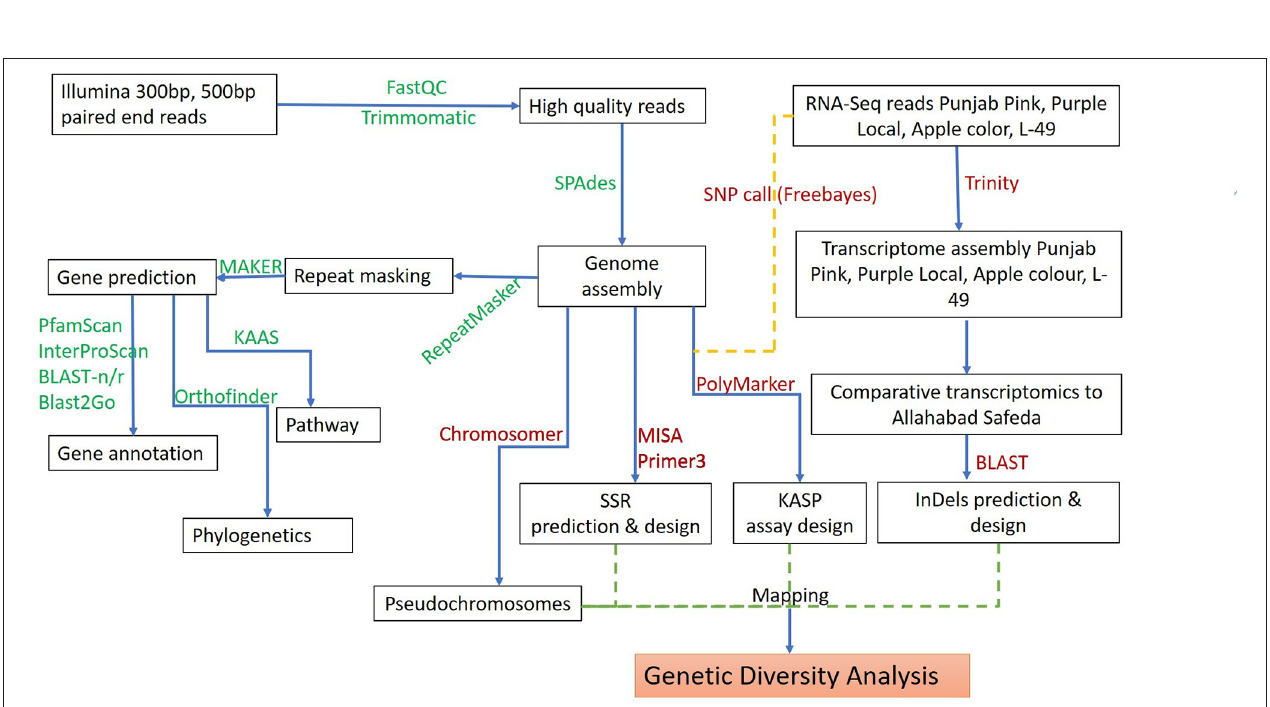
FIGURE 1 | Schematic workflow for de novo whole-genome assembly, annotation, and development of molecular markers in guava.